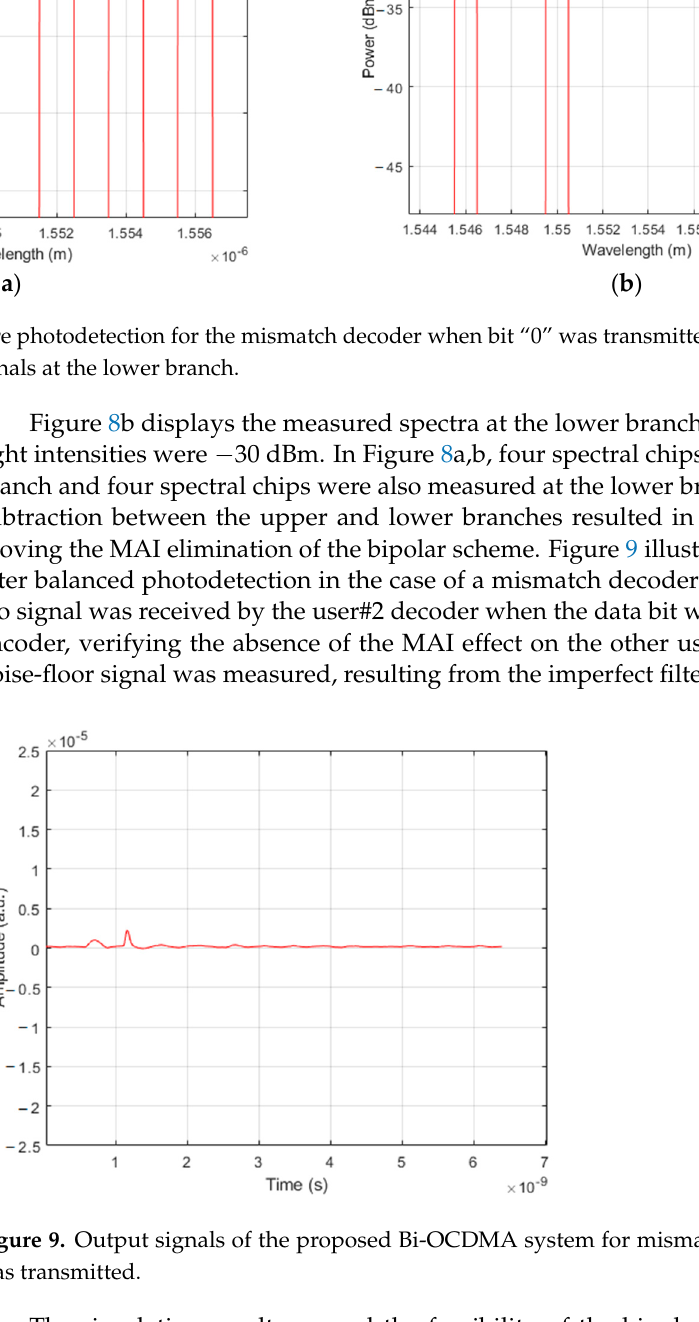
Figure 9. Output signals of the proposed Bi-OCDMA system for mismatch decoder when bit “0” was transmitted.